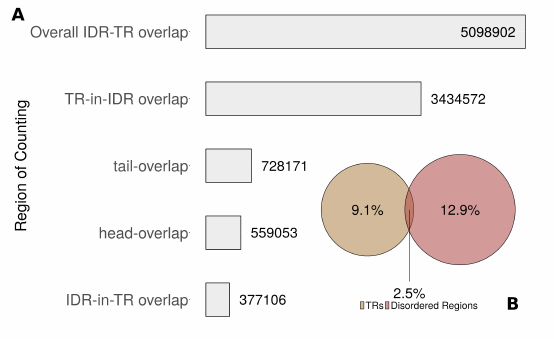
Figure 6. ( A ) Frequency of overlap between TRs and IDRs by type, as an absolute number of residues in all UniprotKB/Swiss-Prot. ( B ) Percentage of residues in UniprotKB/Swiss-Prot found in TRs and/or IDRs. The areas of the circles represent the total AA number in each